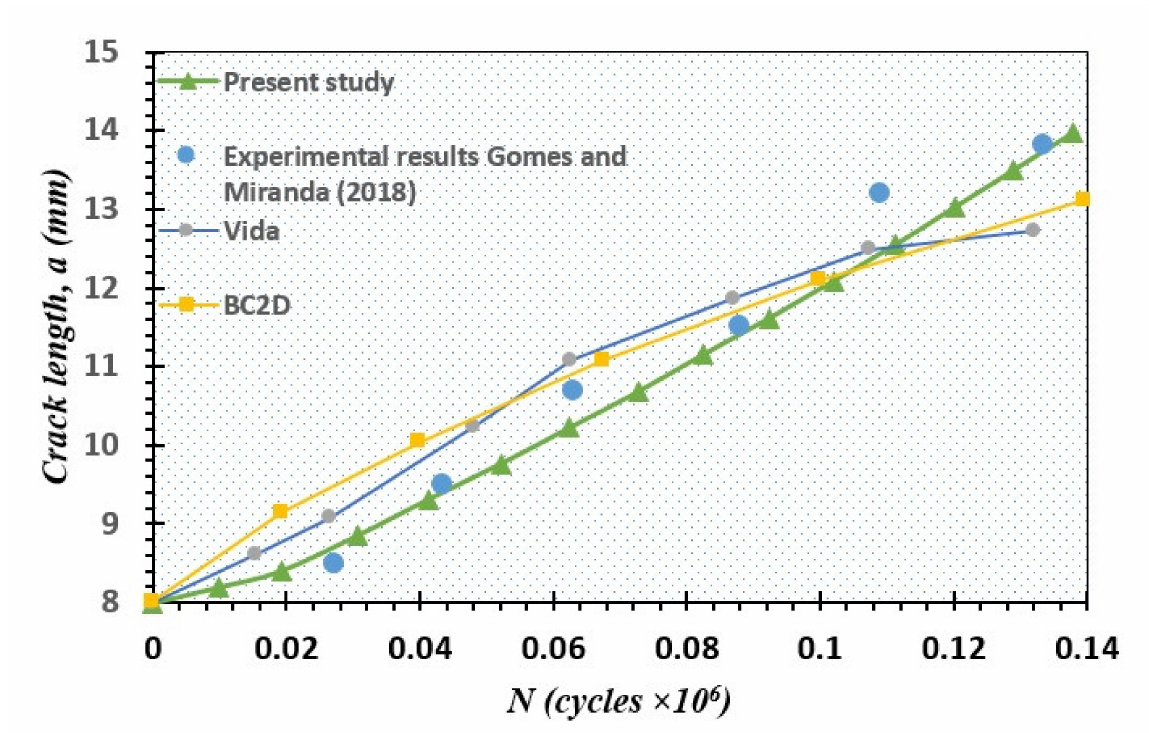
Figure 19. Fatigue life for the modified compact tension specimen